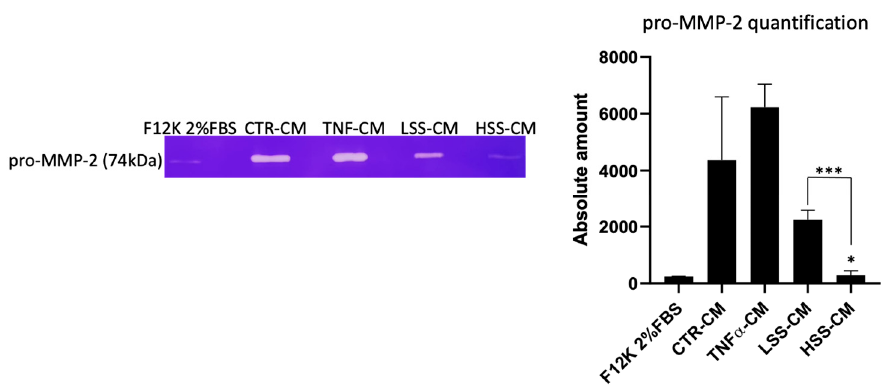
Figure 15. pro-MMP-2 expression evaluated by zymography. On the right, quantitative analysis of the absolute expression of pro-MMP-2 in different conditioned media (CMs) is shown. (* p < 0.05, *** p < 0.005).